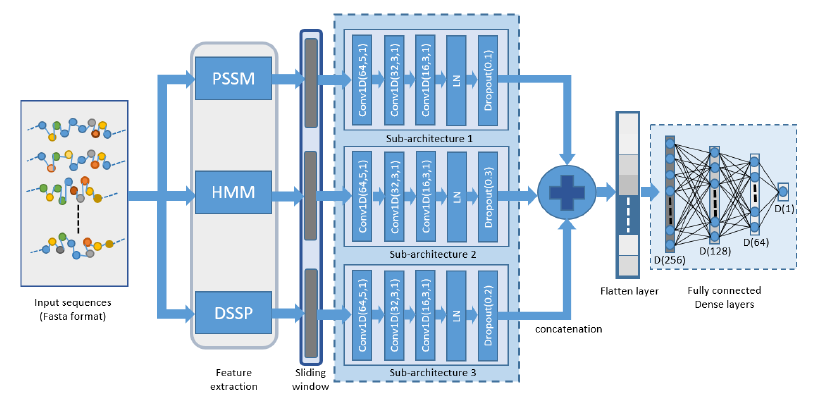
Figure 1. Flow diagram of the proposed